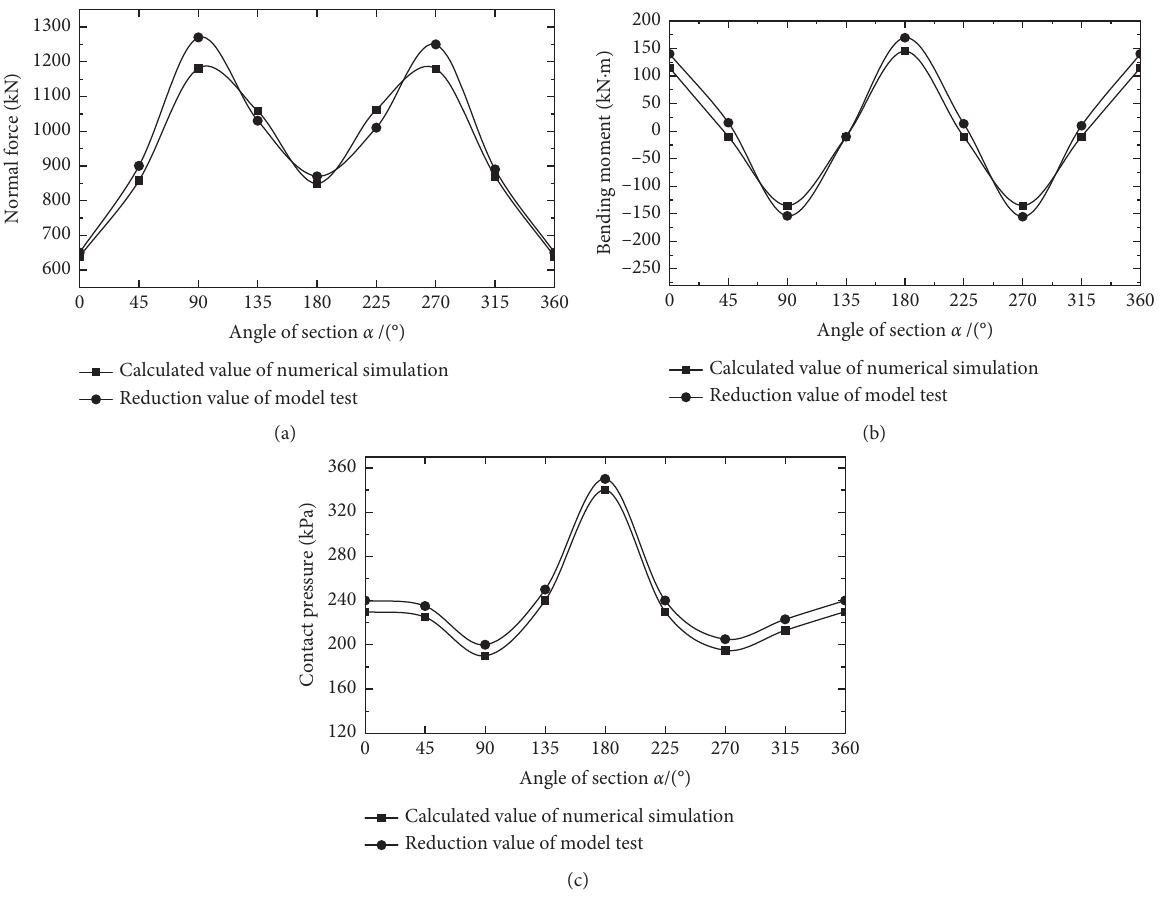
Figure 6: Comparison of numerical simulation values and model test reduction values. (a) Axial force value. (b) Bending moment value. (c) Contact pressure value. Table 2: Beam-spring method mechanical model parameters.